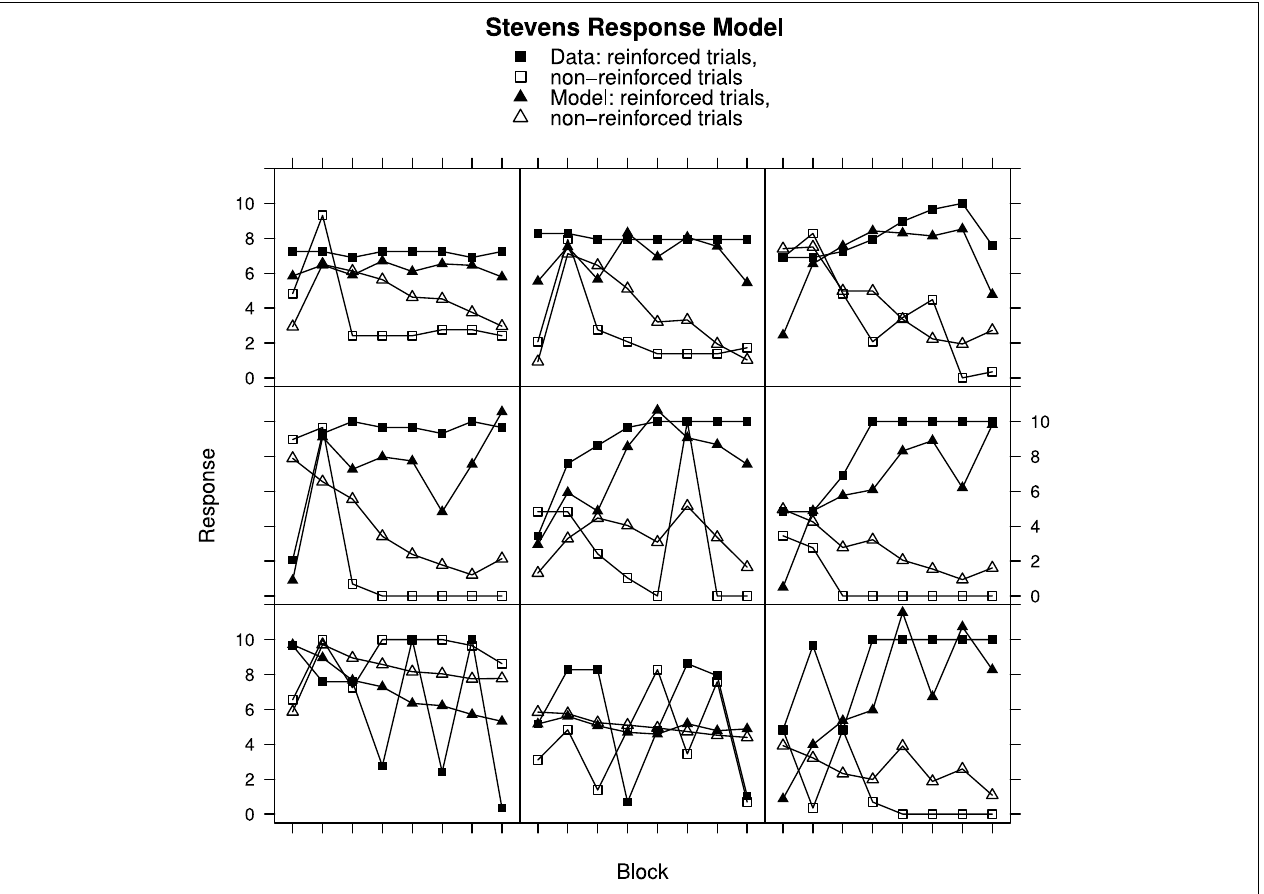
FIGURE 6 | Ratings and MECA Model predictions for reinforced and non-reinforced trials using the Stevens Response Model in Experiment 2. Top row , best fitting model samples. Middle row , intermediate fits. Bottom row , worst fitting model samples. See Results section on page 9 for further